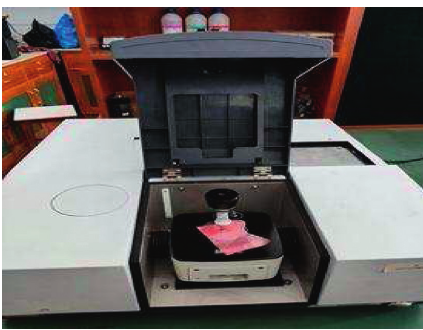
Figure 14: FTIR testing